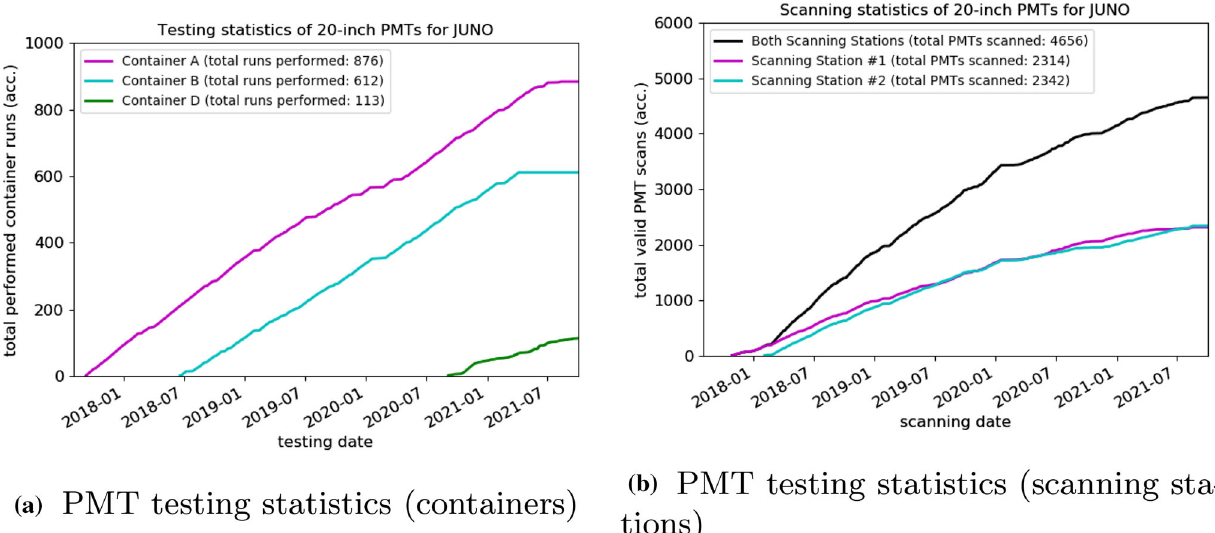
Fig. 7 Time evolution of the PMT testing. Left: more than 52,000 individual PMT characterizations were performed in about 1600 runs using containers #A, #B and #D (some PMTs have been tested multiple times including calibration runs, acceptance tests, re-tests, and continu-